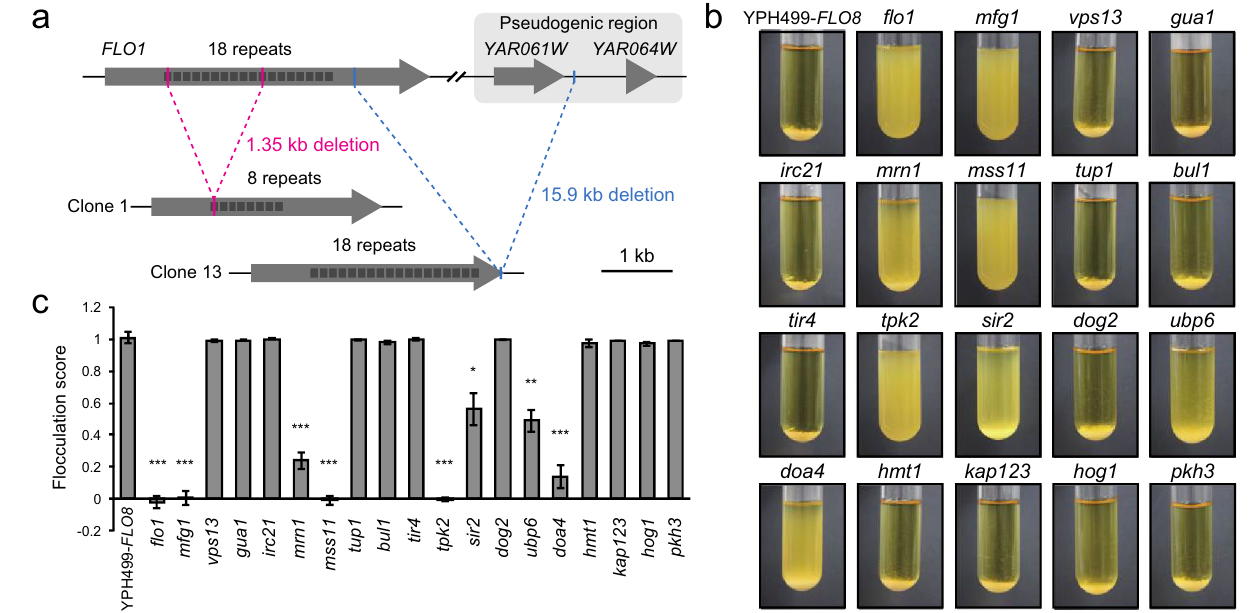
Figure 5. Genes mutated in less-flocculent isolates are associated with flocculation. ( a ) Recombination of homologous sequences in the FLO1 locus. Recombination between intragenic tandem repeats causes the contraction of the FLO1 repeat (from 18 to 8 repeats) in clone 1. In clone 13, FLO1 genes are fused to the homologous sequence in the pseudogenic region located about 16 kb downstream of the FLO1 gene. ( b ) Flocculation behaviors of the deletion mutants of the YPH499- FLO8 strain. ( c ) Flocculation scores of the deletion mutants. P values were calculated using the Welch’s t -test compared to YPH499- FLO8 : * P < 0.05, ** P < 0.01, and *** P < 0.001. Error bars represent standard deviation ( n =